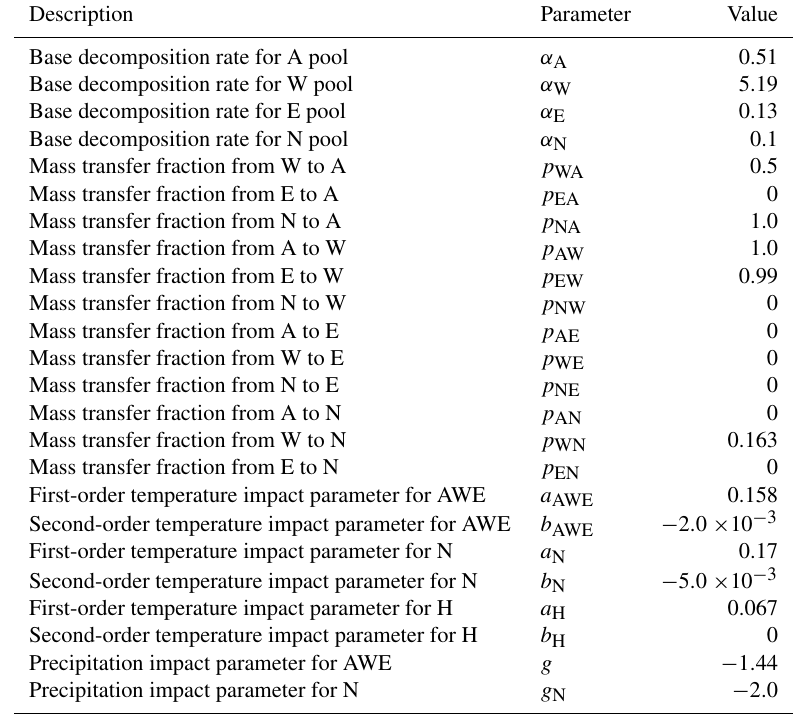
Table A1. Utilised Yasso model parameter